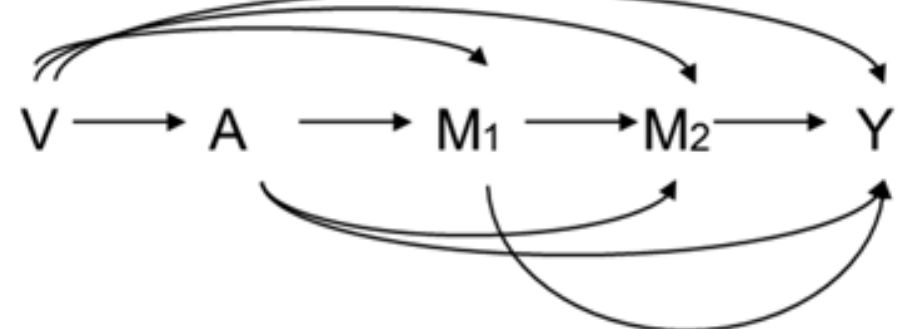
Figure 2: Causal diagrams for a setting with two mediators but no time-varying mediator-outcome confounders.